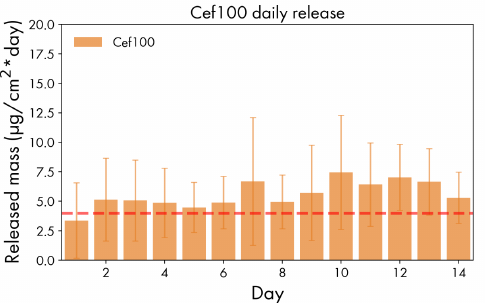
Figure 8. Prolonged release daily profile of Cef100 series. Minimum Inhibitory Concentration (MIC) for MSSA is shown as a red dashed